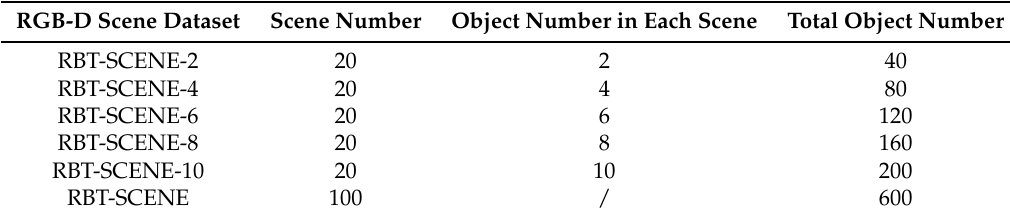
Table 1. RGB-D scene dataset